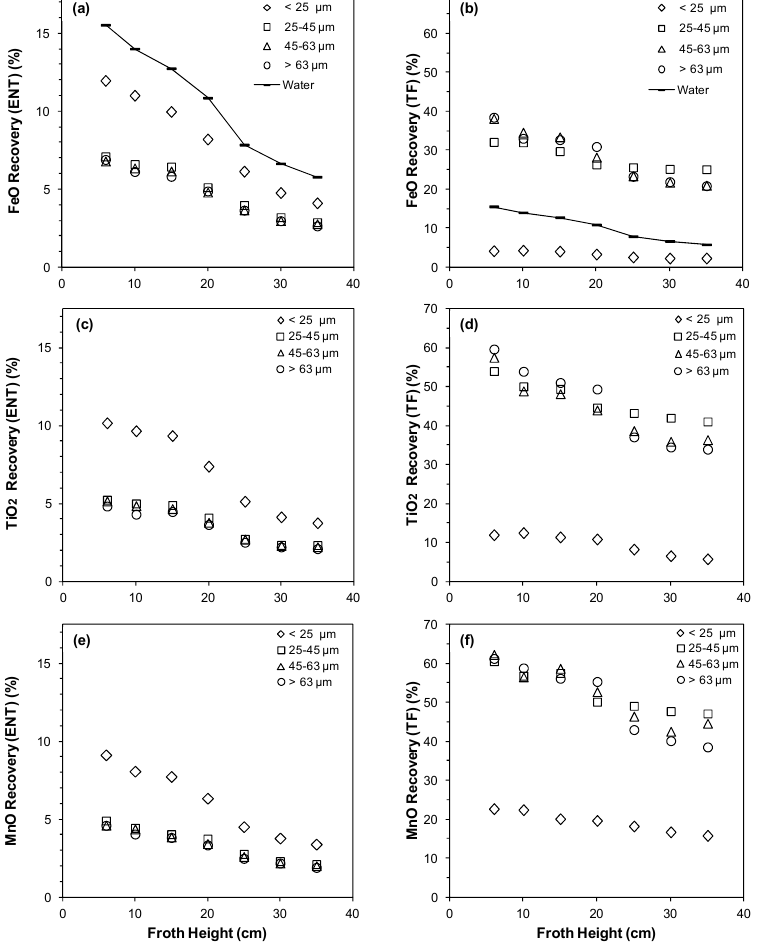
Figure 1. Effect of froth height on the water recovery (a, b) and on the recovery by entrainment (ENT) of iron ( a ), titanium ( c ) and manganese ( e ) oxides and on the recovery by true flotation (TF) of iron ( b ), titanium ( d ) and manganese ( f ) oxides, in four size fractions. As expected, the recovery by true flotation is generally greater than the recovery by